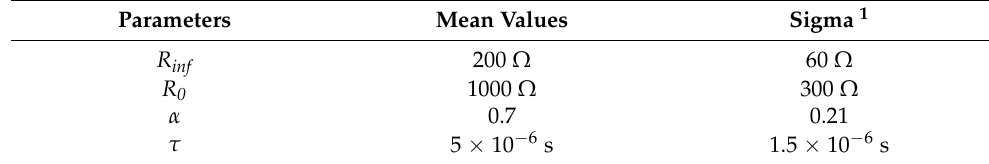
Table 1. Parameters of Cole-Cole model for UQ and